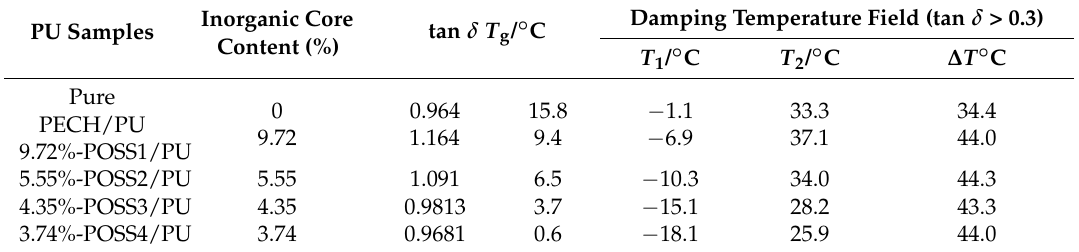
Table 6. Summary of DMA data of PUs with different molecular weights of POSS–PECH.